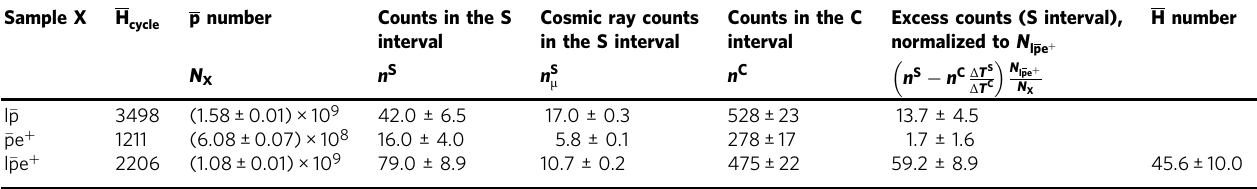
Table 1 Summary of the measured counts. Sample X H